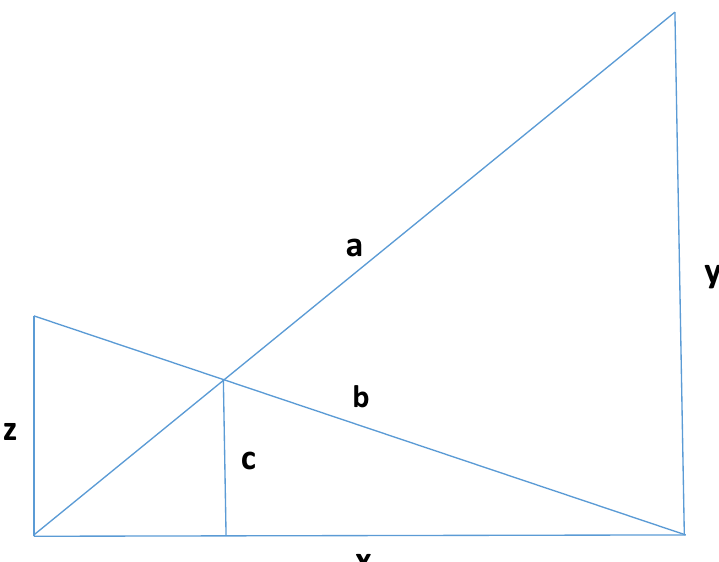
Figure 2. The crossed ladder problem (CLP): find a complete integer parametric representation of the CLP